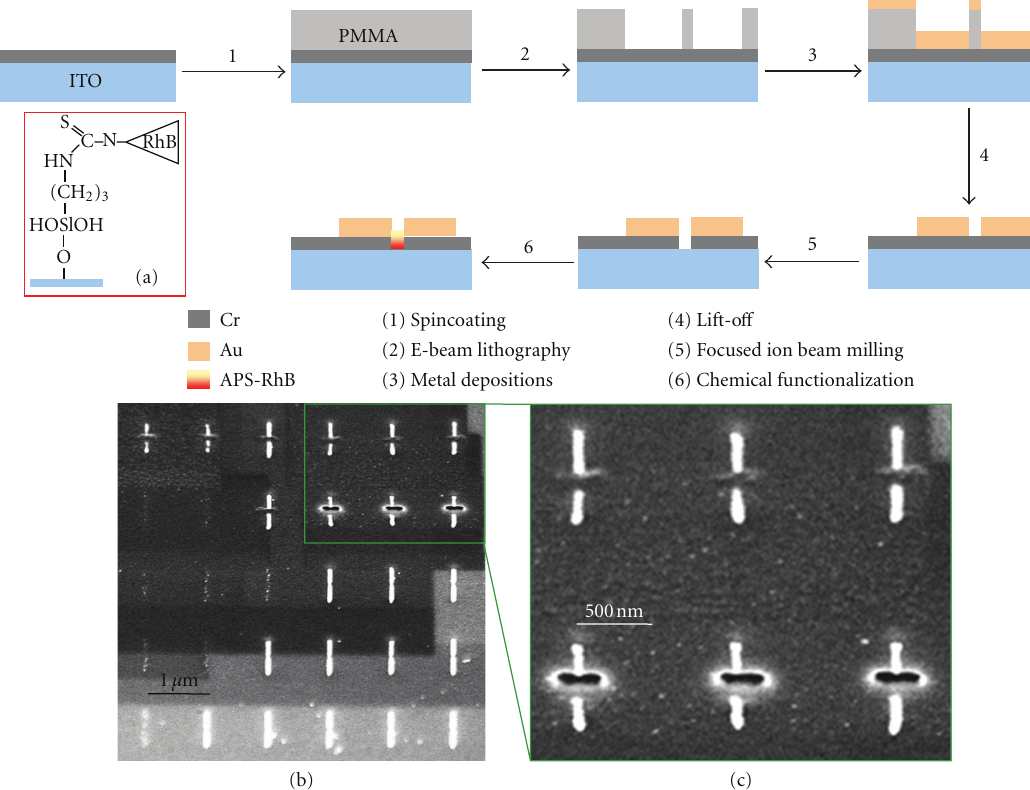
Figure 12: Schematic outline of the fabrication procedure of a molecular plasmonic nanoantenna involving the consecutive application of electron-beam lithography, focused ion beam (FIB) milling, and localized chemical surface functionalization. The inset (a) displays the surface grafting of a Rhodamine B (RhB) fluorophore onto the ITO substrate. The FIB step (step 5) is represented by the SEM images in (b) and (c) where the gap is milled either through a few nanometers of chromium only (top row in (c)) or all the way to the ITO layer (bottom row in